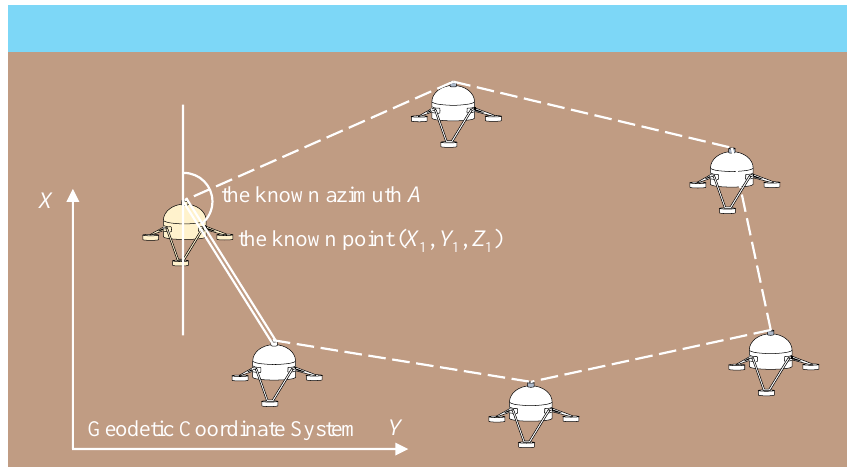
Figure 4. The necessary conditions to constrain a 2D unit network in a geodetic coordinate system. The rank defect network adjustment under the barycentric datum is adopted to solve Equation (10), and the additional datum constraint condition is given in Equation (11).